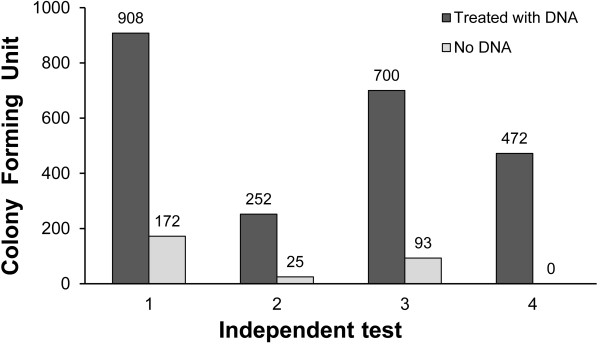
Four more independent experiments of transforming T. sp. strain RQ7 at OD600 of 0.18 ~ 0.20. The number above each column represents the number of Kanr colonies.